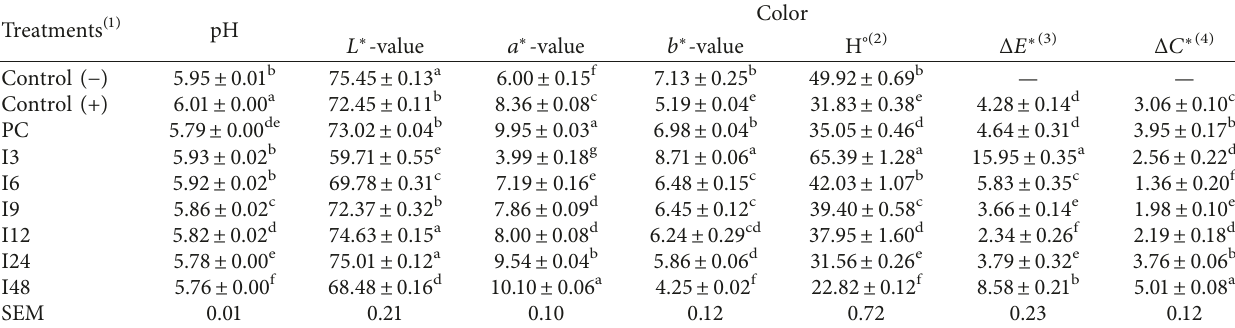
Table 2: Changes of pH and color of cooked cured pork loin with spinach juice and different incubating periods. Treatments